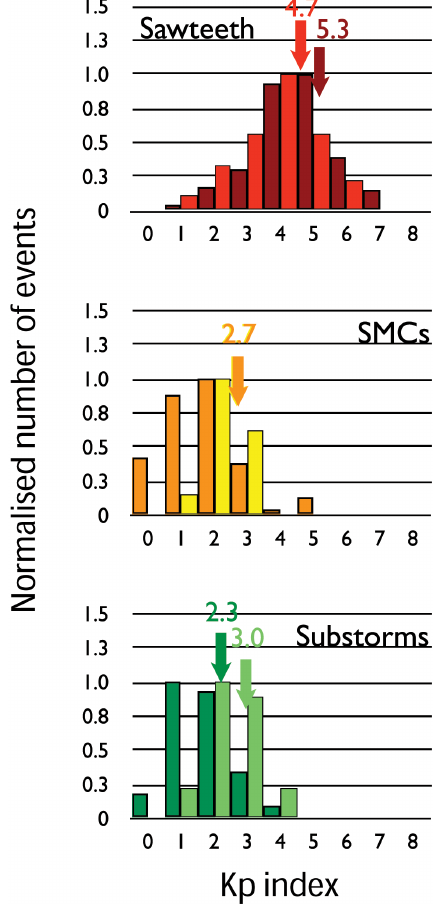
Fig. 1. Distribution of the global activity in terms of K p index. K p value is binned on X and a normalised (described below) number of events on Y axis. The middle panel distribution represents the K p values recorded in the middle of the SMC periods (orange/yellow), while the top and bottom distributions show the K p values at the time of the sawtooth (brown/red) and substorm events (green/light green), respectively. The lighter coloured histograms represent the subsets of constant solar wind electric field. The arrows and their la- belling numbers are the median values of each distribution. All his- tograms are normalised to overcome the different number of events in subsets of each event